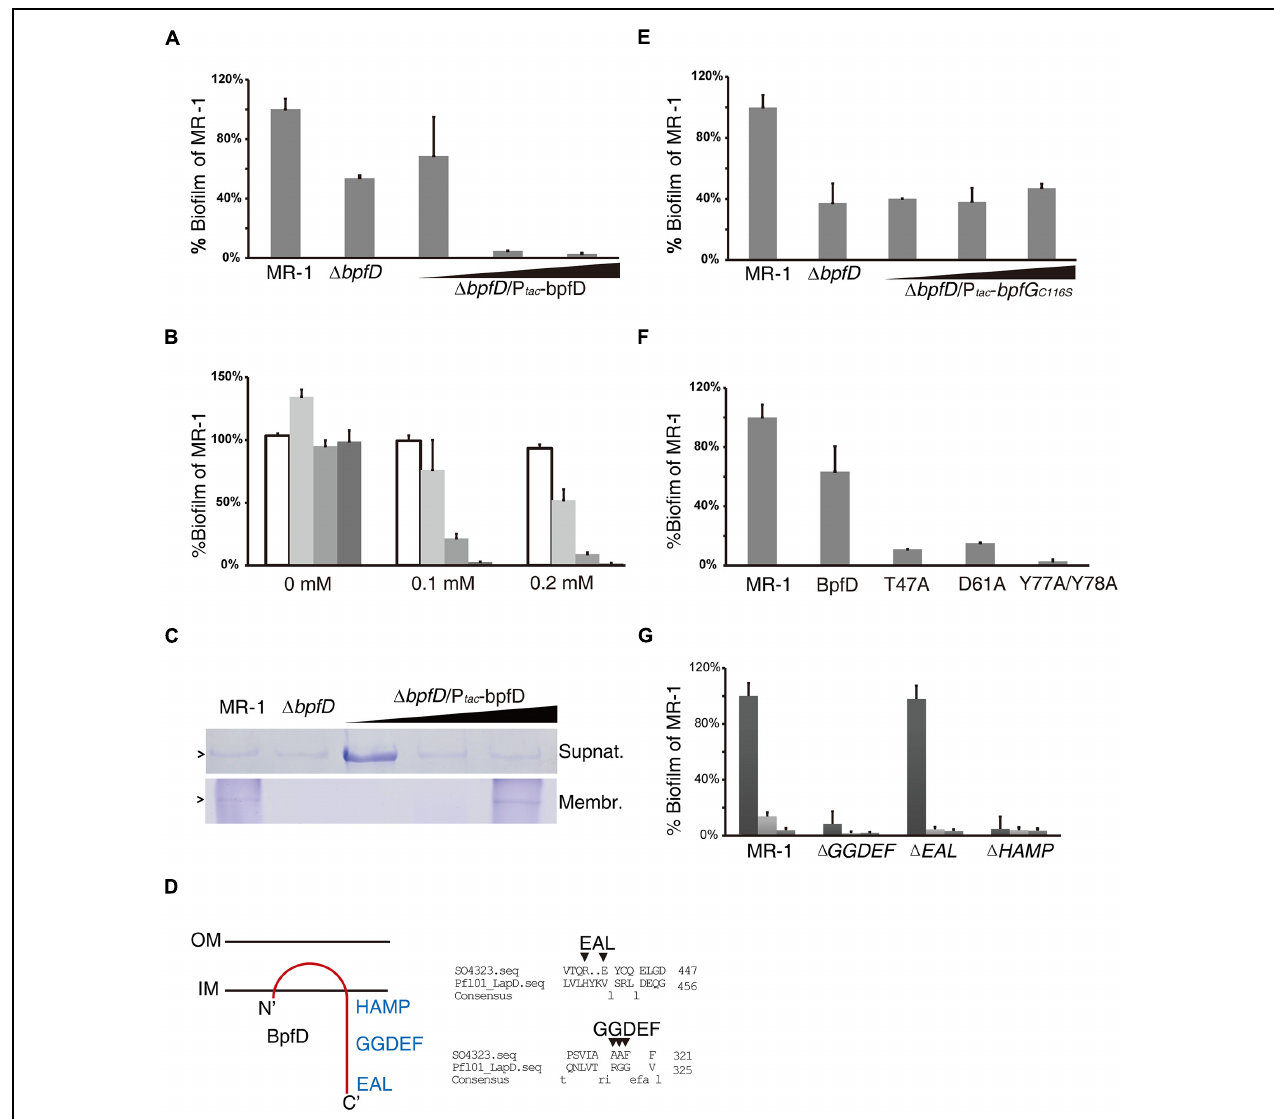
FIGURE 4 | BpfD is an inner membrane protein regulating biofilm formation by interacting with BpfG and BpfA. (A) The biphasic impact of BpfD. (cid:2) bpfD mutant was complemented with a plasmid carrying a P tac - bpfD construct, treated with different concentrations of IPTG. Error bar represents SE of three experiments. (B) A biofilm assay examining wild-type strain carrying P tac -GFP (white), (cid:2) bpfD (cid:2) bpfG strain carrying P tac - bpfDbpfG (light gray), P tac - bpfD (gray) and P tac - bpfG (dark gray). All P tac recombinant plasmids were treated with a range of concentrations of IPTG as indicated. Error bar represents SE of three experiments. (C) BpfA from the extracellular and membrane preparations were visualized by protein electrophoresis for the indicated strains, treated